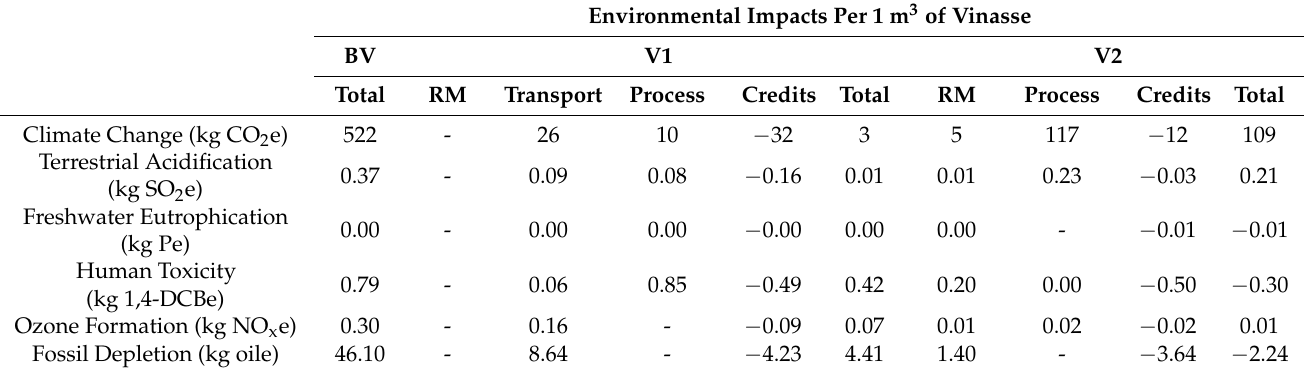
Table 4. Environmental impact potentials for vinasse management